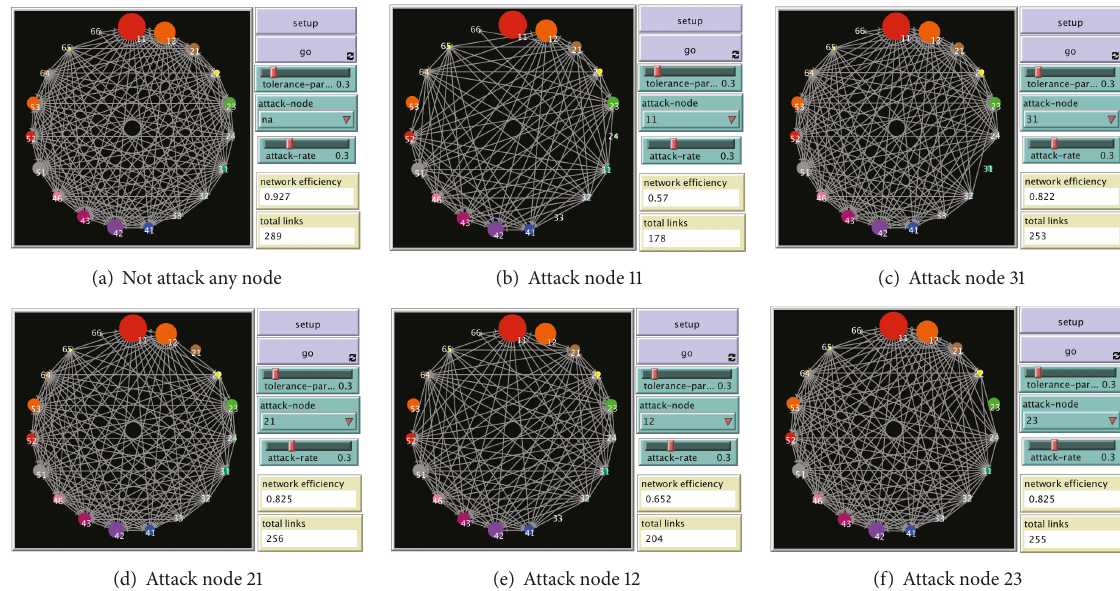
Figure 5: Land system networks after attacking the nodes and connected links. Note . In this example, tolerance parameter and area shrinkage are set at 0.3. The original network and five nodes with largest INC are shown here. NetLogo interface shows the network efficiency and remaining total links in each network graph after the corresponding node is attacked.